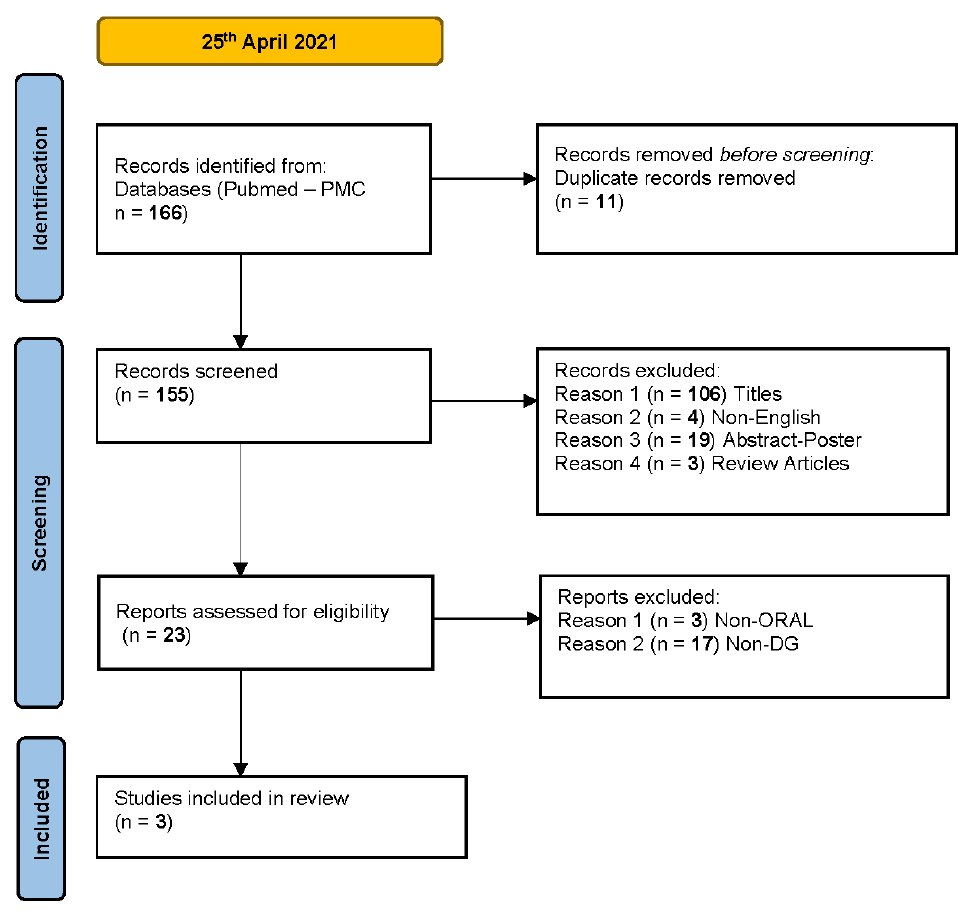
Figure 1. The flowchart summarizes the steps in the selection process for systematic review. The PICOS information about the three selected papers and their contents is given in Table 1. Table 1. PICOS details of the three selected studies .